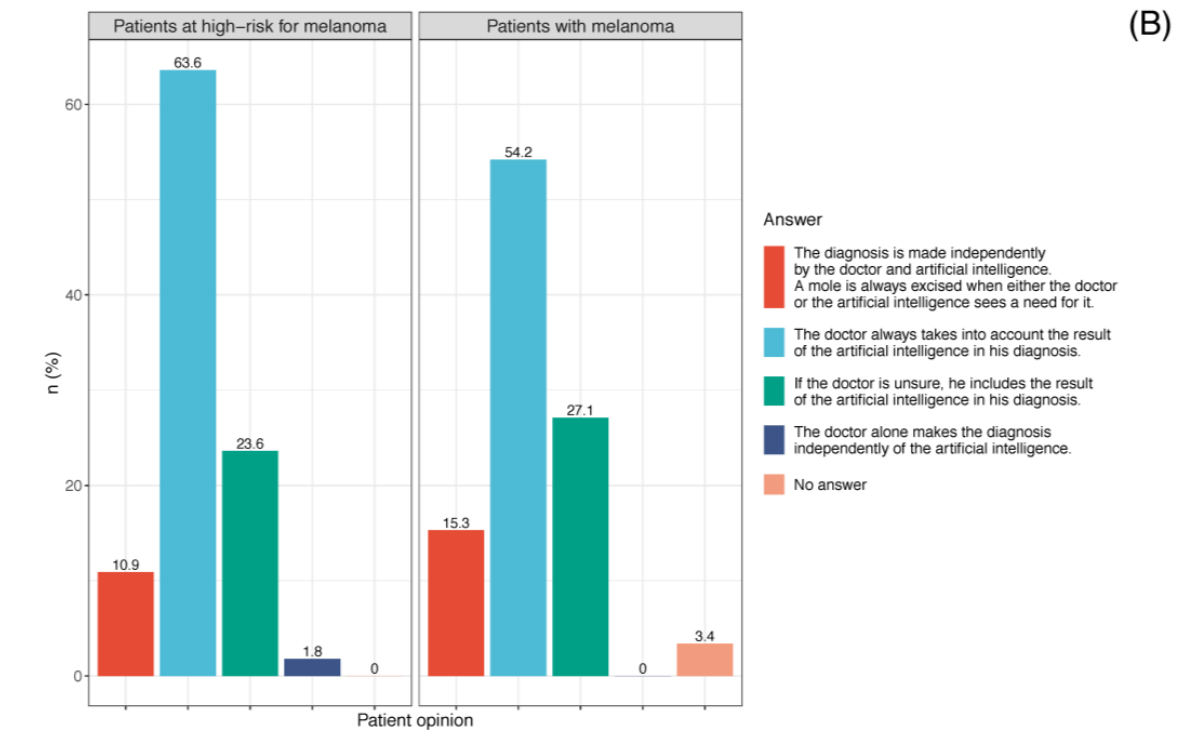
Figure 8. ( A ) Patient preference for mole assessment (patients at high-risk for melanoma, n = 55; patients with melanoma, n = 59); ( B ) Patient preference for AI in skin cancer screening (patients at high-risk for melanoma, n = 55; patients with melanoma, n = 59).